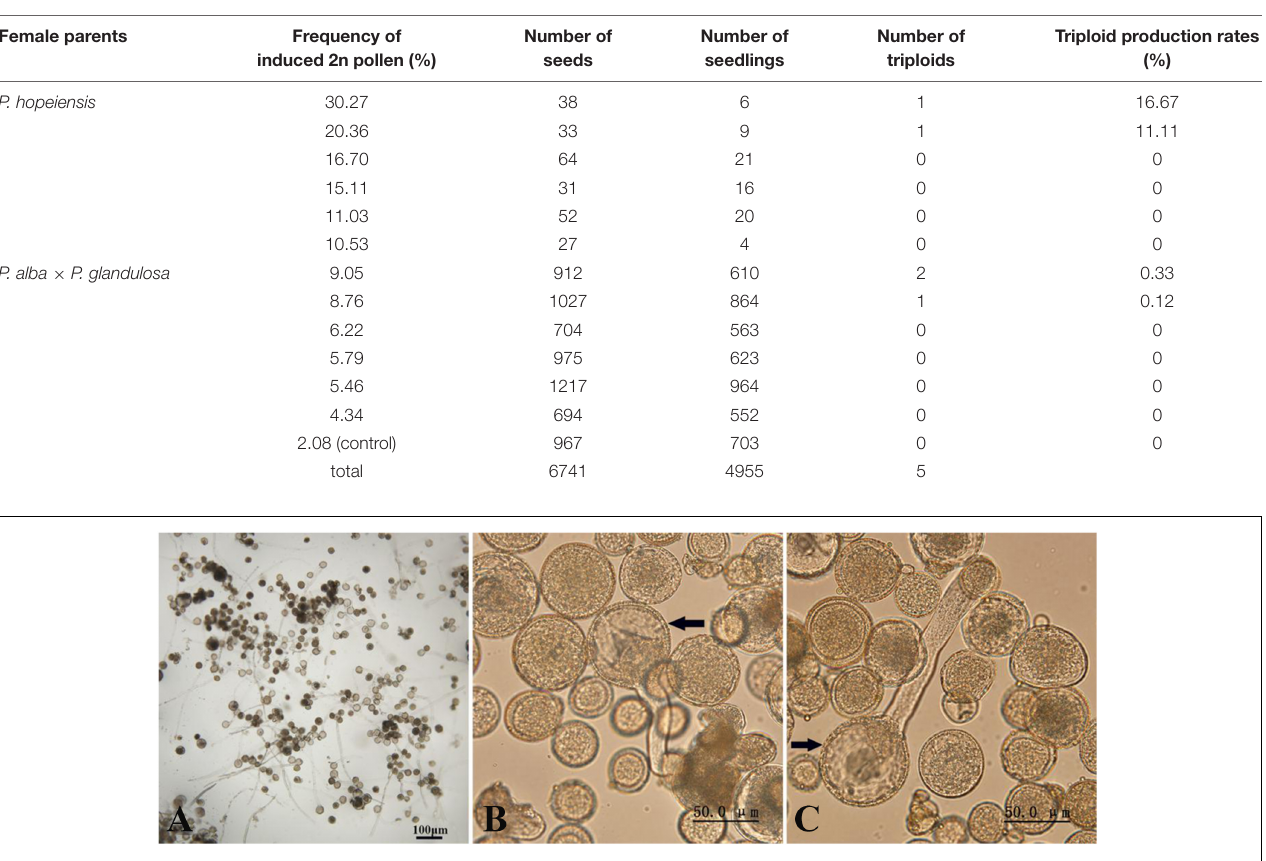
TABLE 2 | Triploid production by crossing colchicine-induced P. canescens 2n pollen with haploid female gametes in P. hopeiensis and P. alba × P. glandulosa.